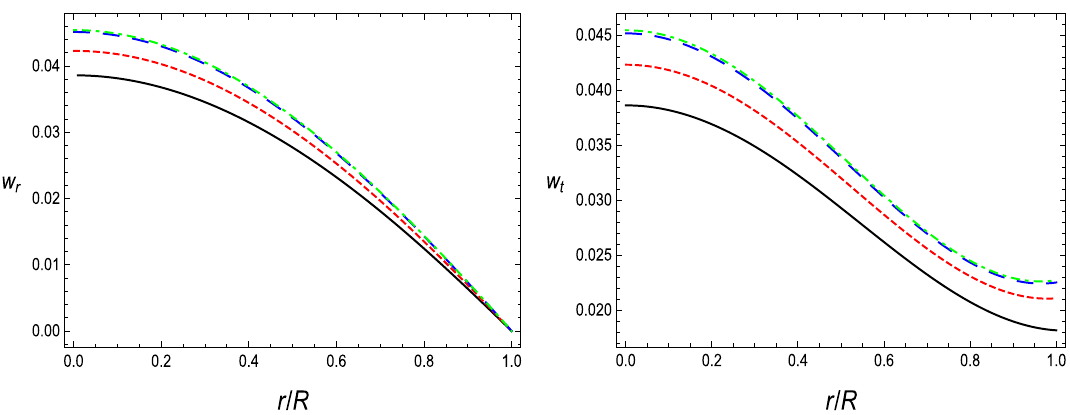
Fig. 7 Profiles of EoS components ( w r = p r /ρ and w t versus radial coordinate, r . The same set of numerical values has been used to plot these graphs as mentioned in